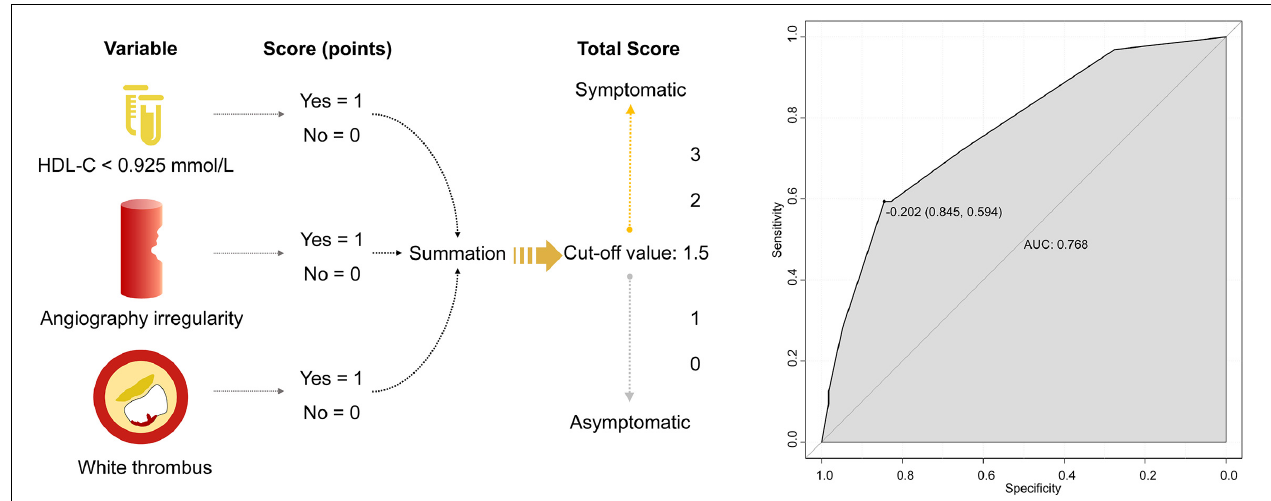
FIGURE 2 | The three-item scale of symptomatic carotid plaque and the ROC curve. HDL-C, high-density lipoprotein cholesterol; ROC, receiver operating characteristic; AUC, operating characteristic curve.